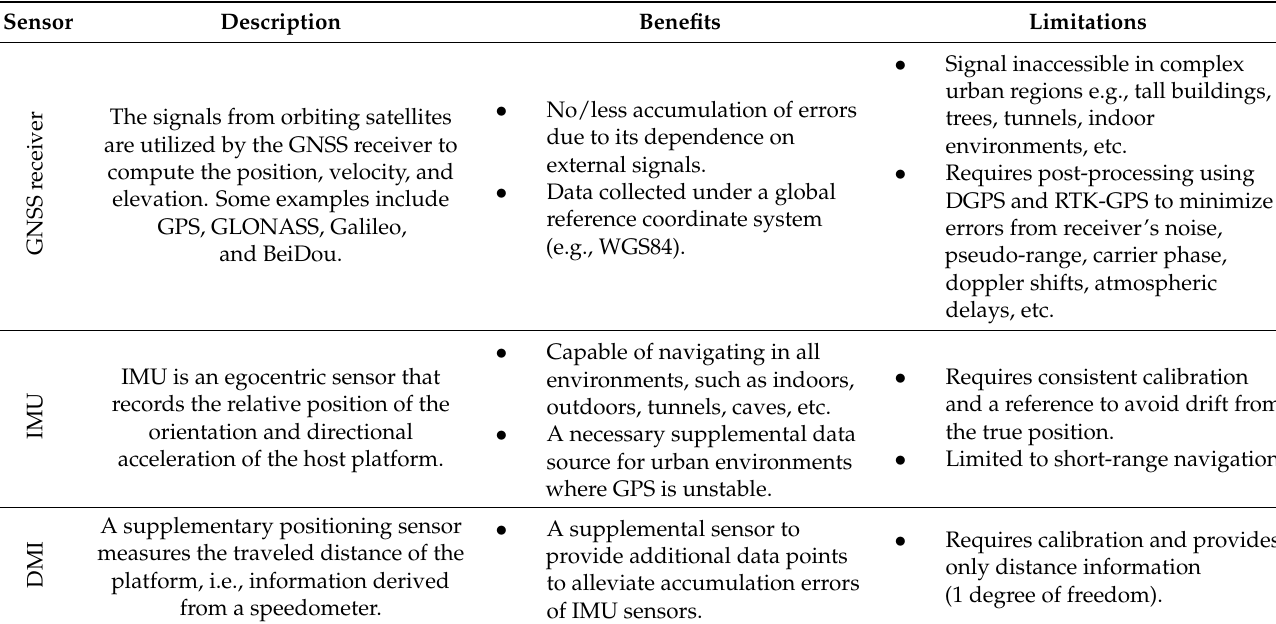
Table 1. Positioning sensors